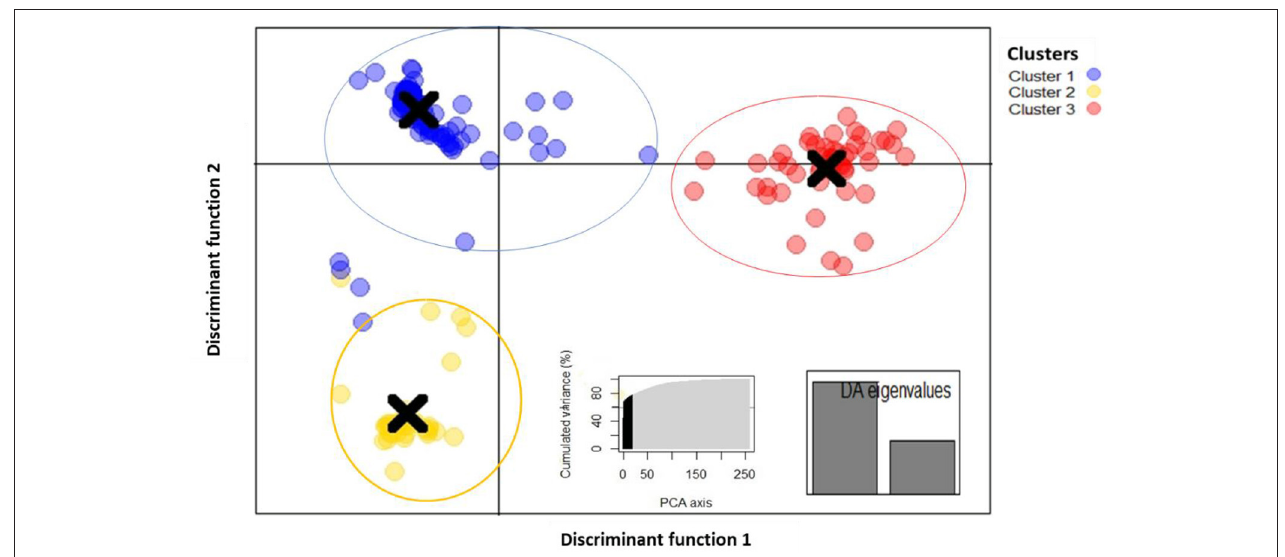
FIGURE 5 | Discriminant analysis of principal components plot of the 259 fonio genotypes. using 688 SNP markers grouped into 3 clusters using 2 discriminant functions. Within the graph PCA axis (left) and eigenvalues (right).